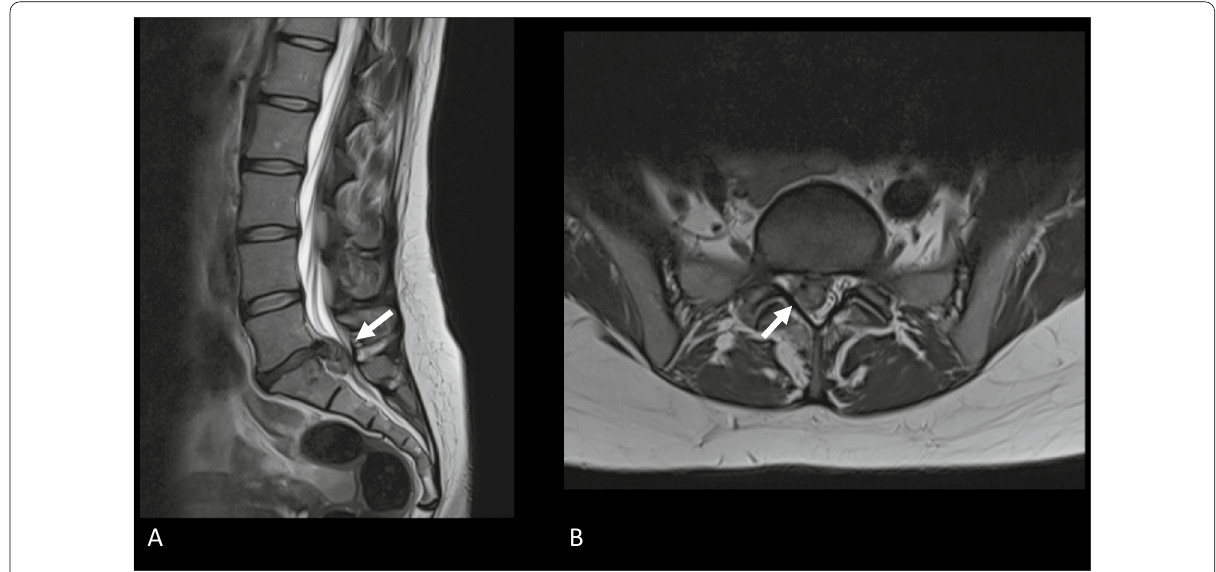
Fig. 7 MRI of the lumbar spine demonstrates a large disk herniation on level L5–S1. A Sagittal T2-weighted MRI depicts disk protrusion at level L5– S1. A close relation with the cauda equina roots can be observed. B Axial T2-weighted MRI shows the protruding disk at level L5–S1 occupying part of the central zone and right subarticular zone. Cauda equina roots are displaced to the contralateral side of the dural